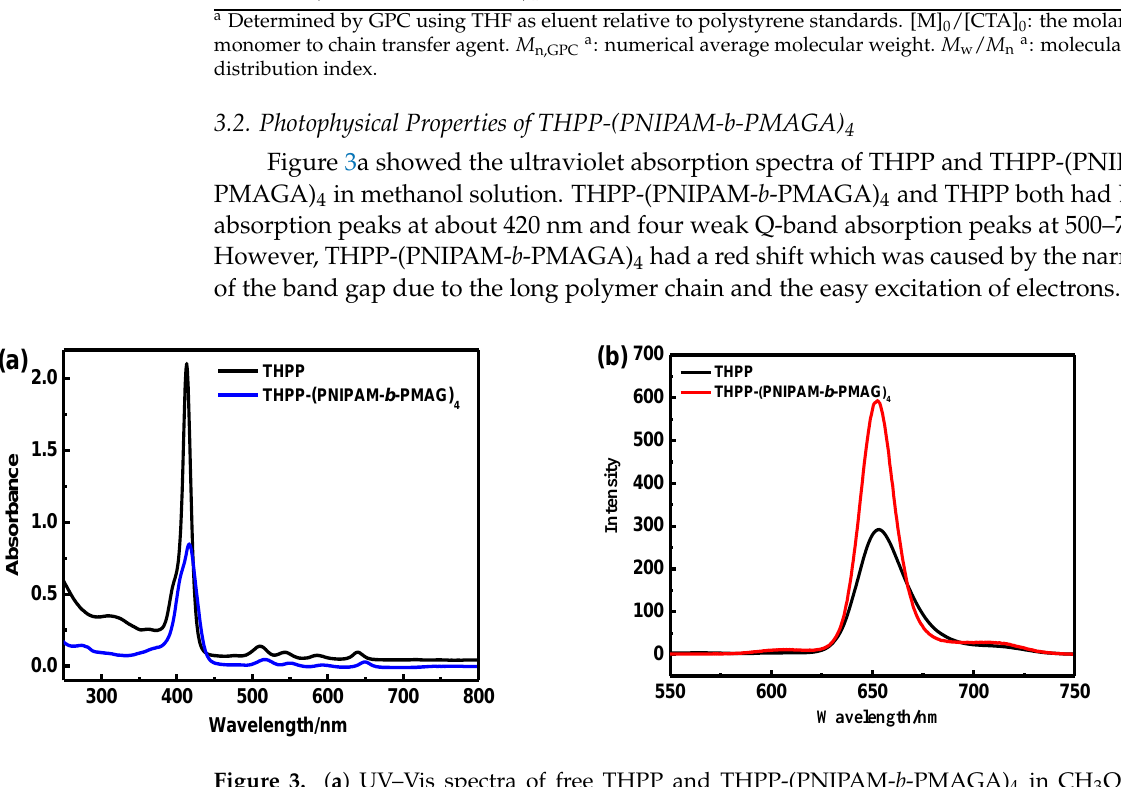
Figure 3. ( a ) UV–Vis spectra of free THPP and THPP-(PNIPAM- b -PMAGA) 4 in CH 3 OH solution; ( b ) emission spectra of free THPP and THPP-(PNIPAM- b -PMAGA) 4 in CH 3 OH solution (0.125 mg mL −1 ).